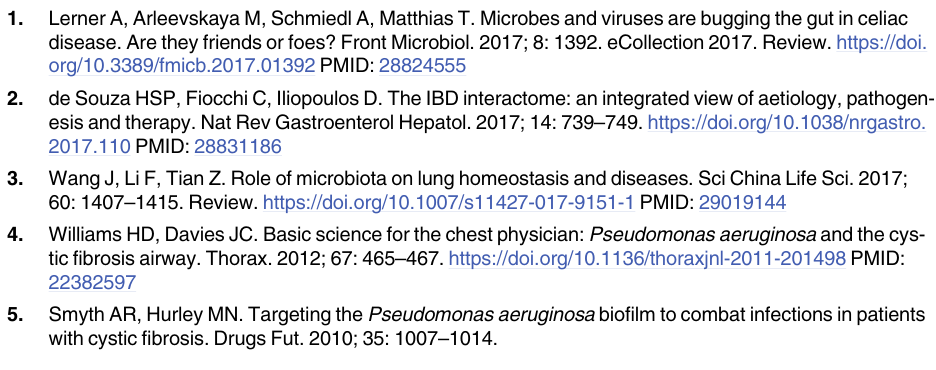
S1 Table. Data sets used in this